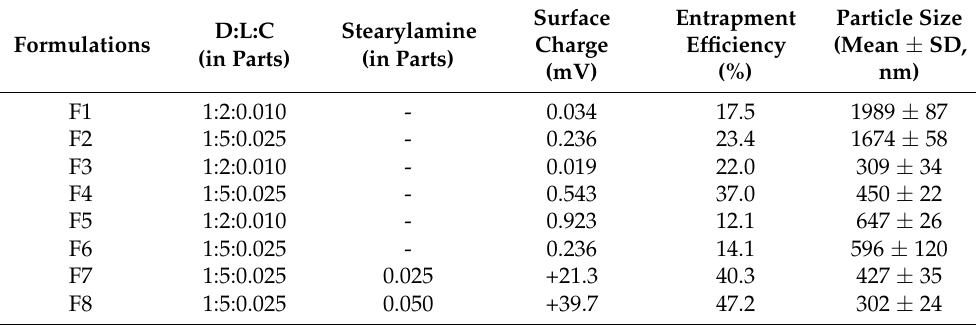
Figure 3. DSC thermograms of AKH and proliposomal formulation (F8). 2.6. In Vitro Dissolution Studies The in vitro dissolution profiles were obtained for the optimized formulations in 0.01 N HCl. The proliposomal formulations were optimized based on their particle size and